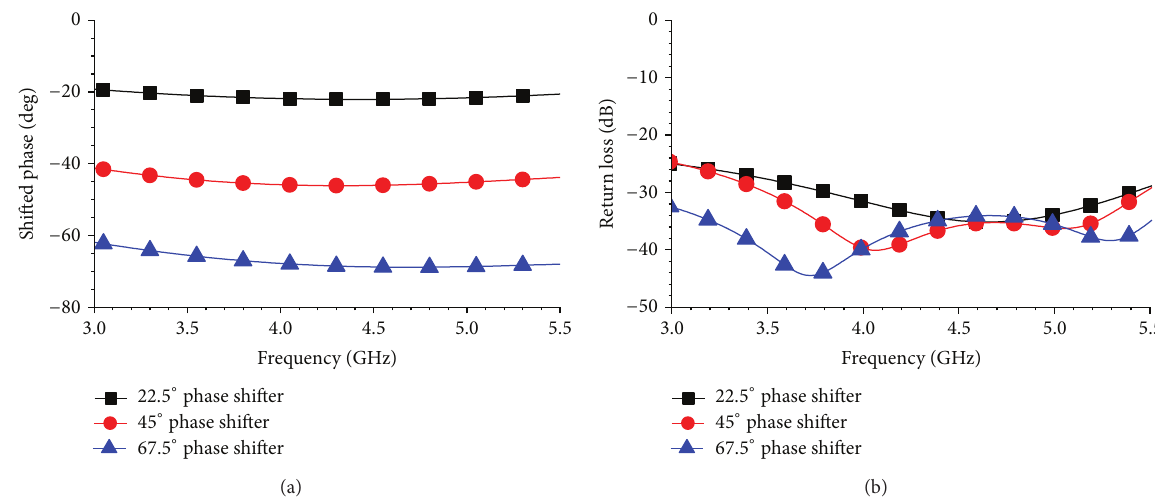
Figure 6: The simulated results of matching and transmission performance of the improved Schiffman phase shifters.